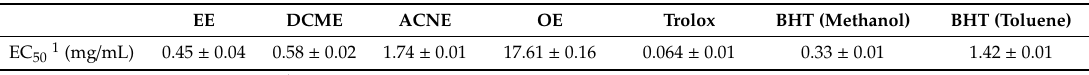
Table 2. DPPH free radical scavenging activities of H. plicatum ethanol (EE), dichloromethane